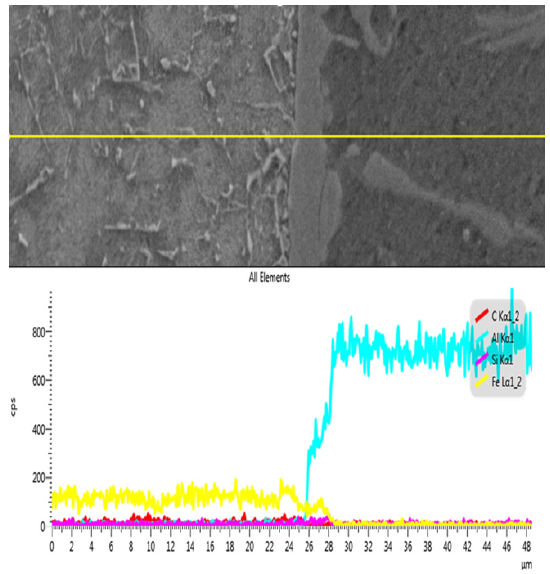
Figure 9. EDS results between the welding seam and SS400 steel interface layer.